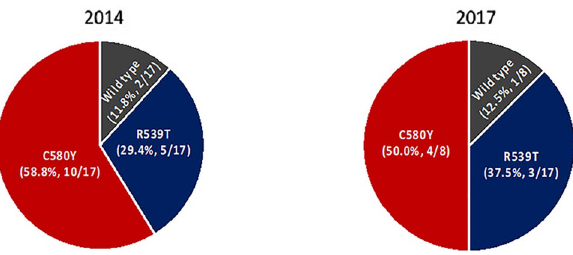
Figure 4. Pie charts representing proportions of mutations of pfkelch gene which were observed in 12 P. falciparum isolates from Ubon Ratchathani in 2014 and 8 P. falciparum isolates from Ubon Ratchathani in 2017.